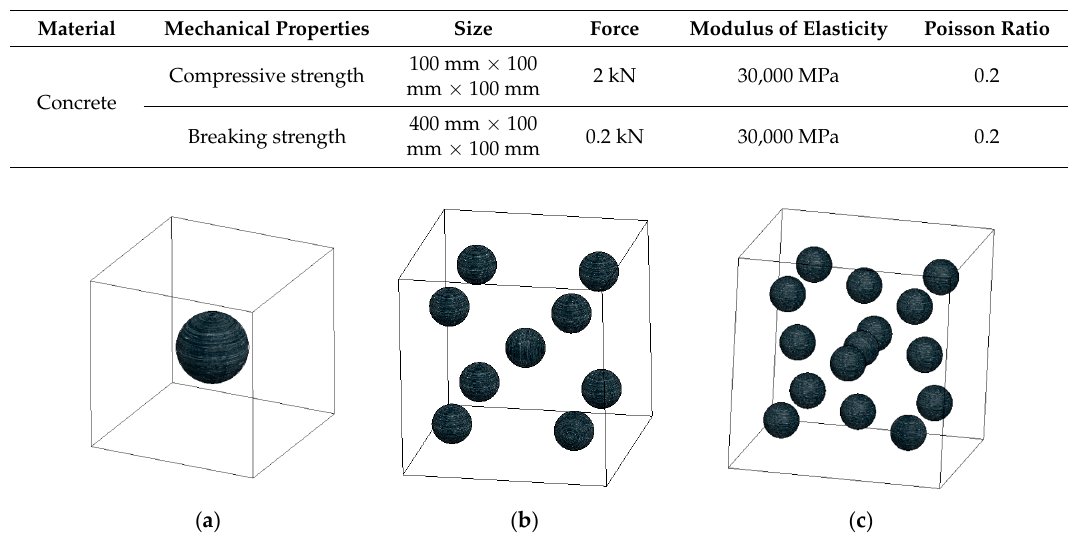
Table 4. Modeling parameters.